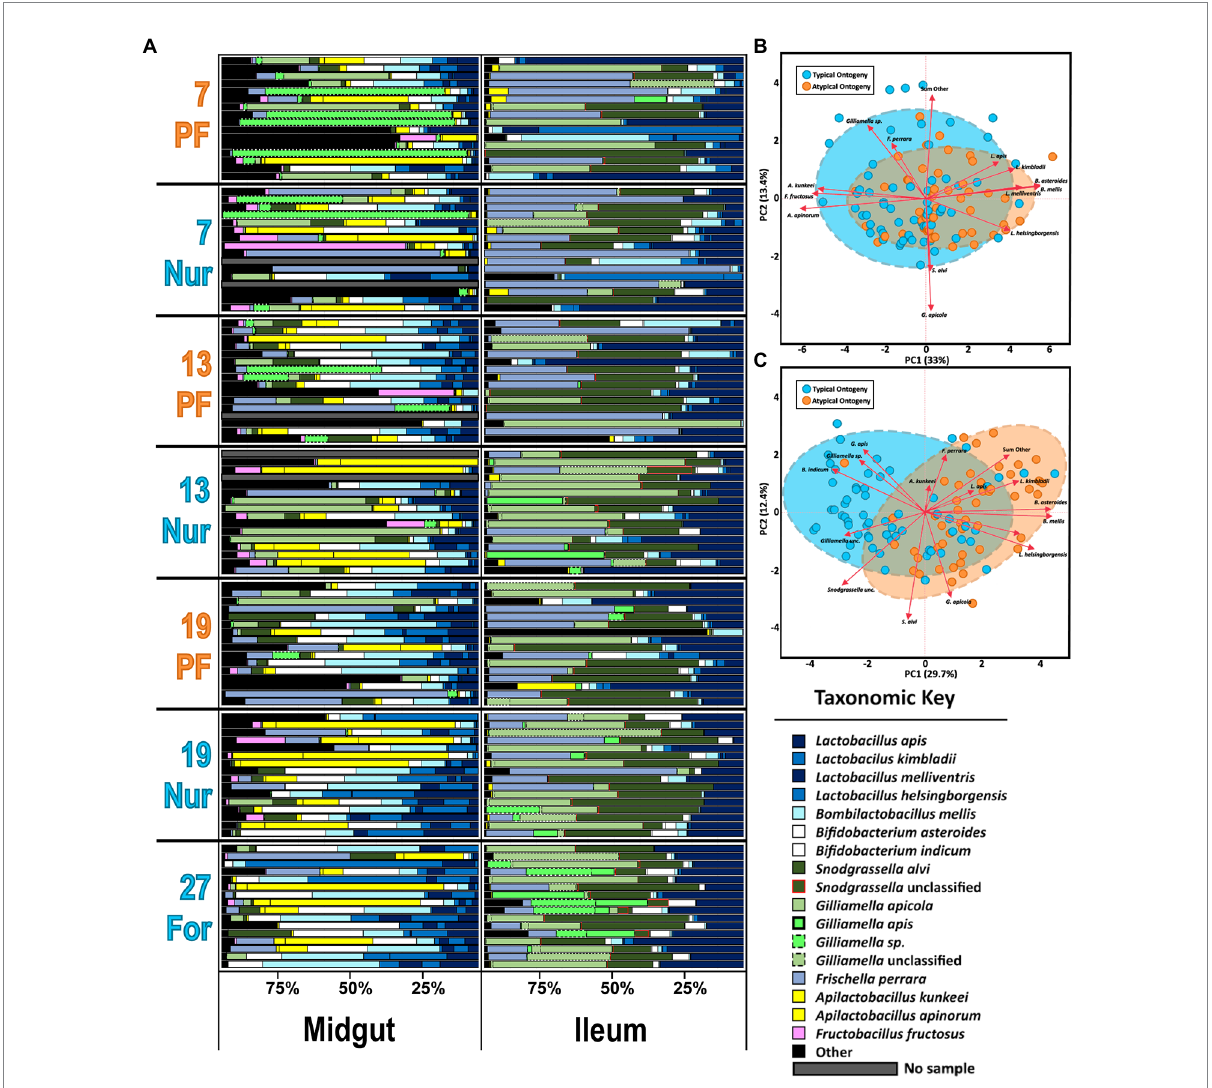
FIGURE 2 (A) The honey bee microbiota of the midgut and ileum by age and task. Color-coded bars represent relative abundance corrected by species- specific 16S rRNA gene copy number. Black represents diversity abundance, midgut: ASV’s 14–740 and ileum: ASV’s 16–214. (B,C) Principal component analysis of the midgut and Ileum, respectively, based on the most abundant ASVs. Clustered groups of points contain similar groupings of taxa with similar microbiota ratio abundances. Longer ASV vectors result from greater variation in CLR-adjusted scores. Density ellipses cover 90% of plots for each